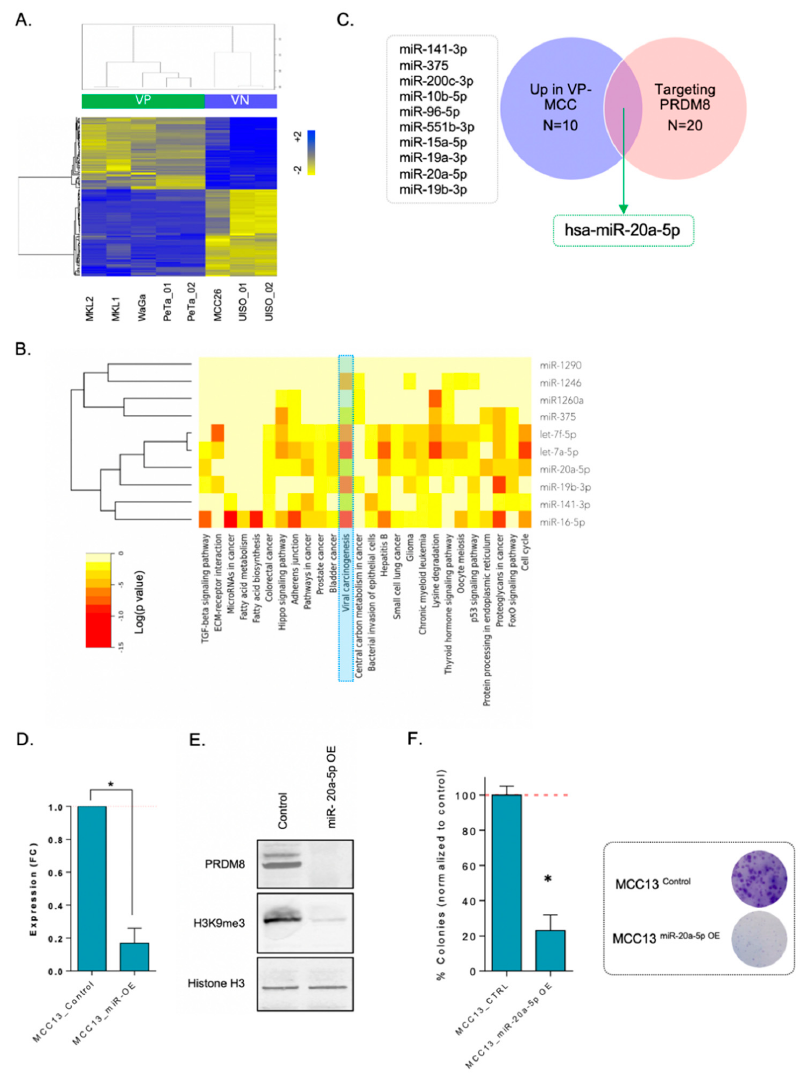
Figure 4. ( A ) Heatmap shows differentially expressed microRNA (miRNAs) in VP- vs. VN-MCC cell lines from microarray data analysis (false discovery rate ( FDR ) <0.05). ( B ) miRNA pathway analysis using mirPath v.3 in the top differentially expressed miRNAs, showing enriched pathways (i.e., viral carcinogenesis and miRNAs involved in cancer). ( C ) Intersection of top upregulated miRNAs in VP-MCC with top miRNAs that could potentially target PRDM8 (scored using miRWalk) indicates miR-20a-5p as the only miRNA that can target PRDM8 and at the same time is downregulated in VN-MCCs. ( D ) Overexpressing miR-20a-5p using miRNA mimic decreases PRDM8 expression level significantly in MCC13 cells. ( E ) Immunoblot shows that PRDM8 protein levels are decreased upon miR-20a-5p overexpression. Ectopic overexpression of miR-20a-5p also led to the decrease in H3K9me3 levels. Histone H3 is used as the control. ( F ) Colony formation assay performed in MCC13 cells compared to miR-20a-5p-overexpressed MCC13 cells indicated lower clonogenicity capability upon overexpression of miR-20a-5p. Representative figures of colonies in MCC13 cells are shown. * p -value < 0.05.